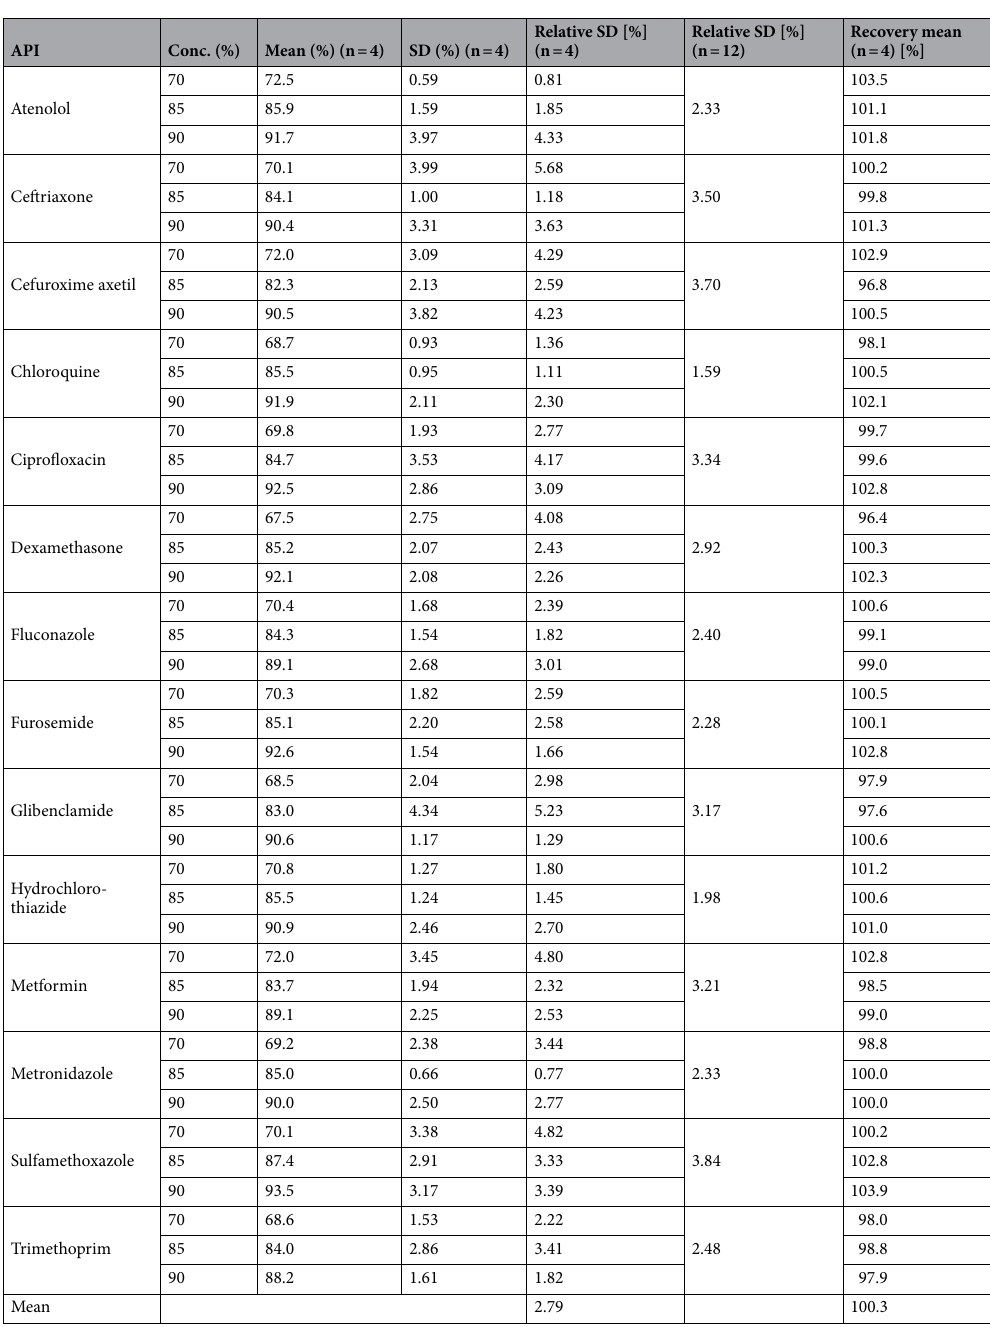
their numerical values are listed in Supplementary Table